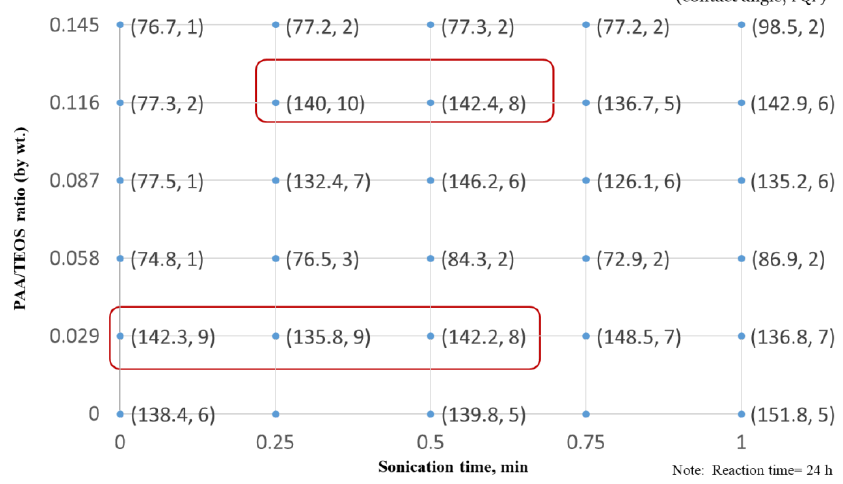
Figure 6. Results of CA and FQI scores obtained for various PAA/TEOS ratios (by wt.) versus the sonication time.